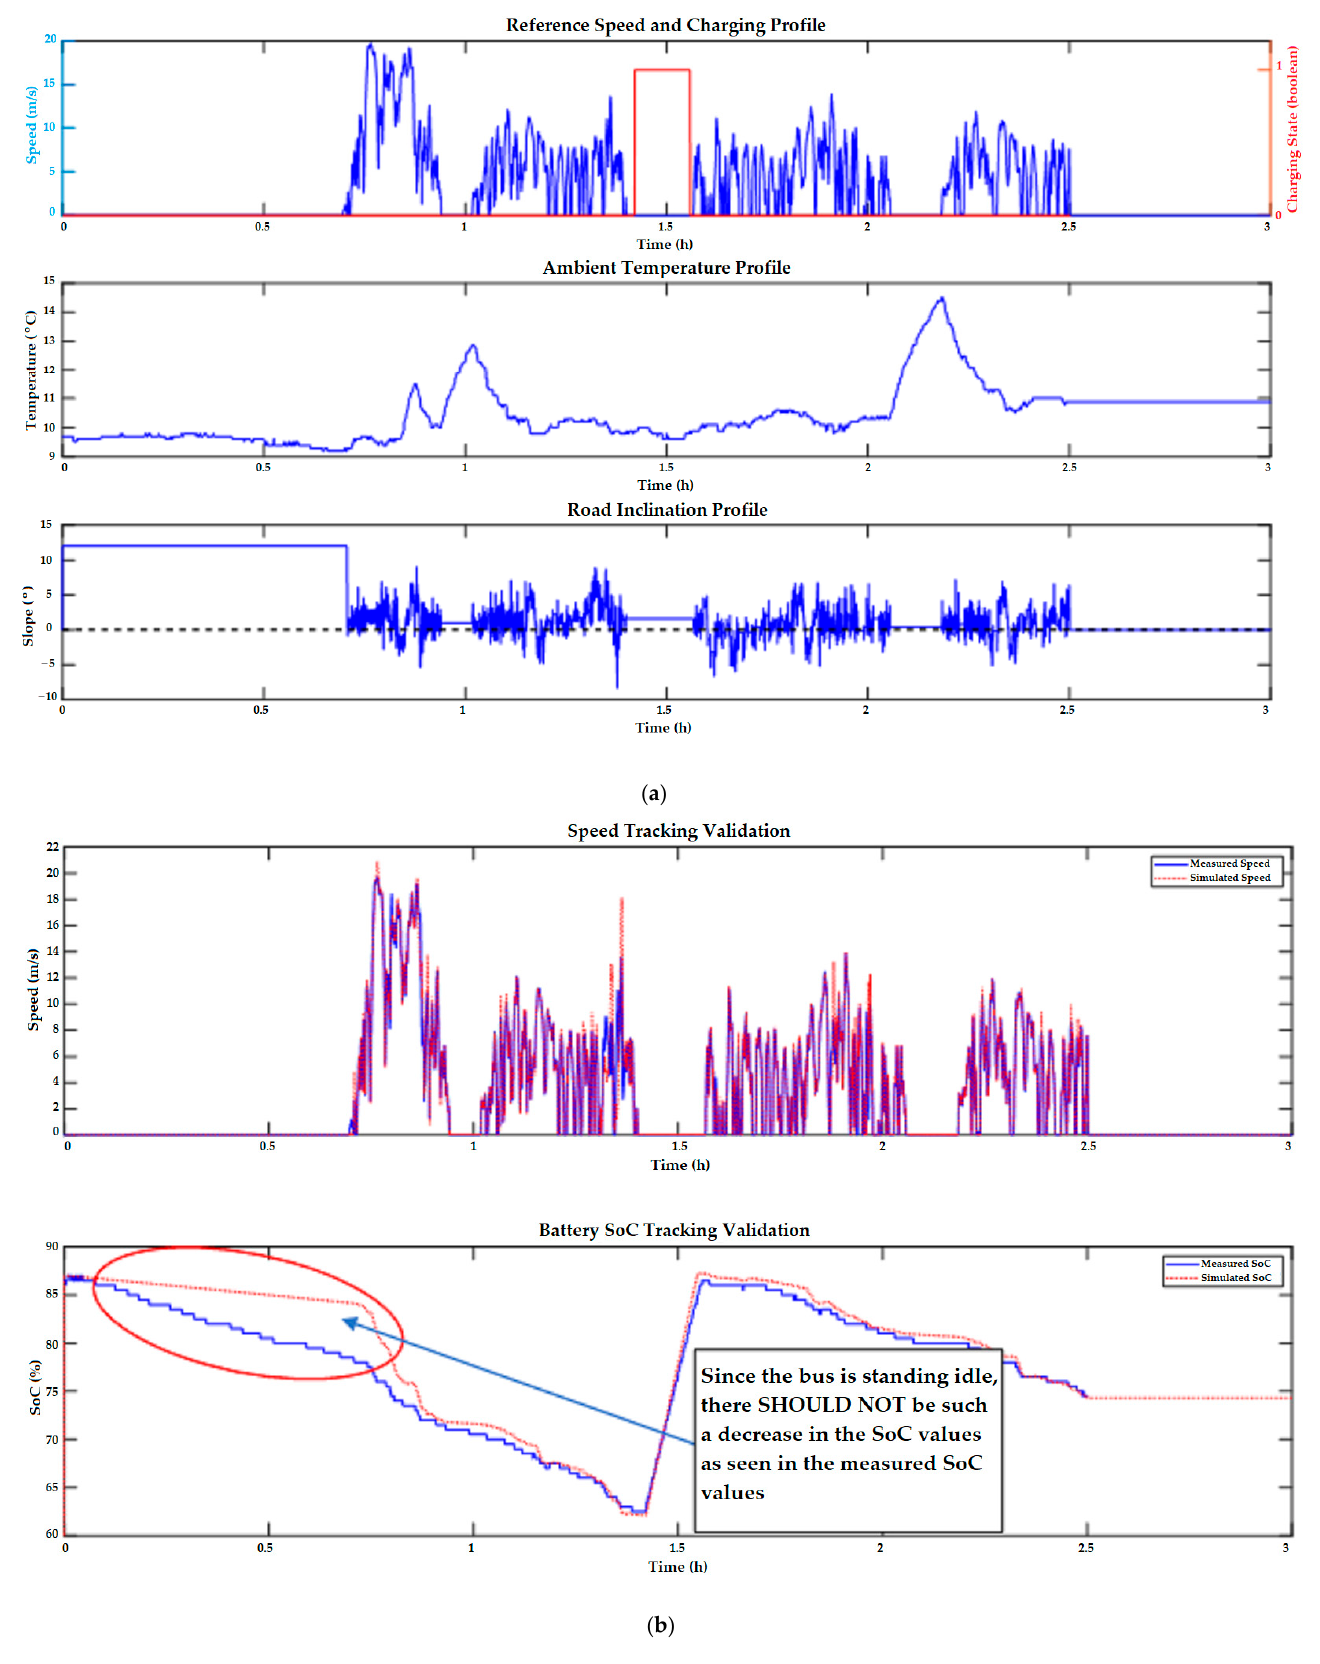
Figure 9. Validation of the October 13th demonstration of 12 m bus in Gothenburg city using the estimates in Table 6. ( a ) Scenario inputs, ( b ) Scenario outputs and